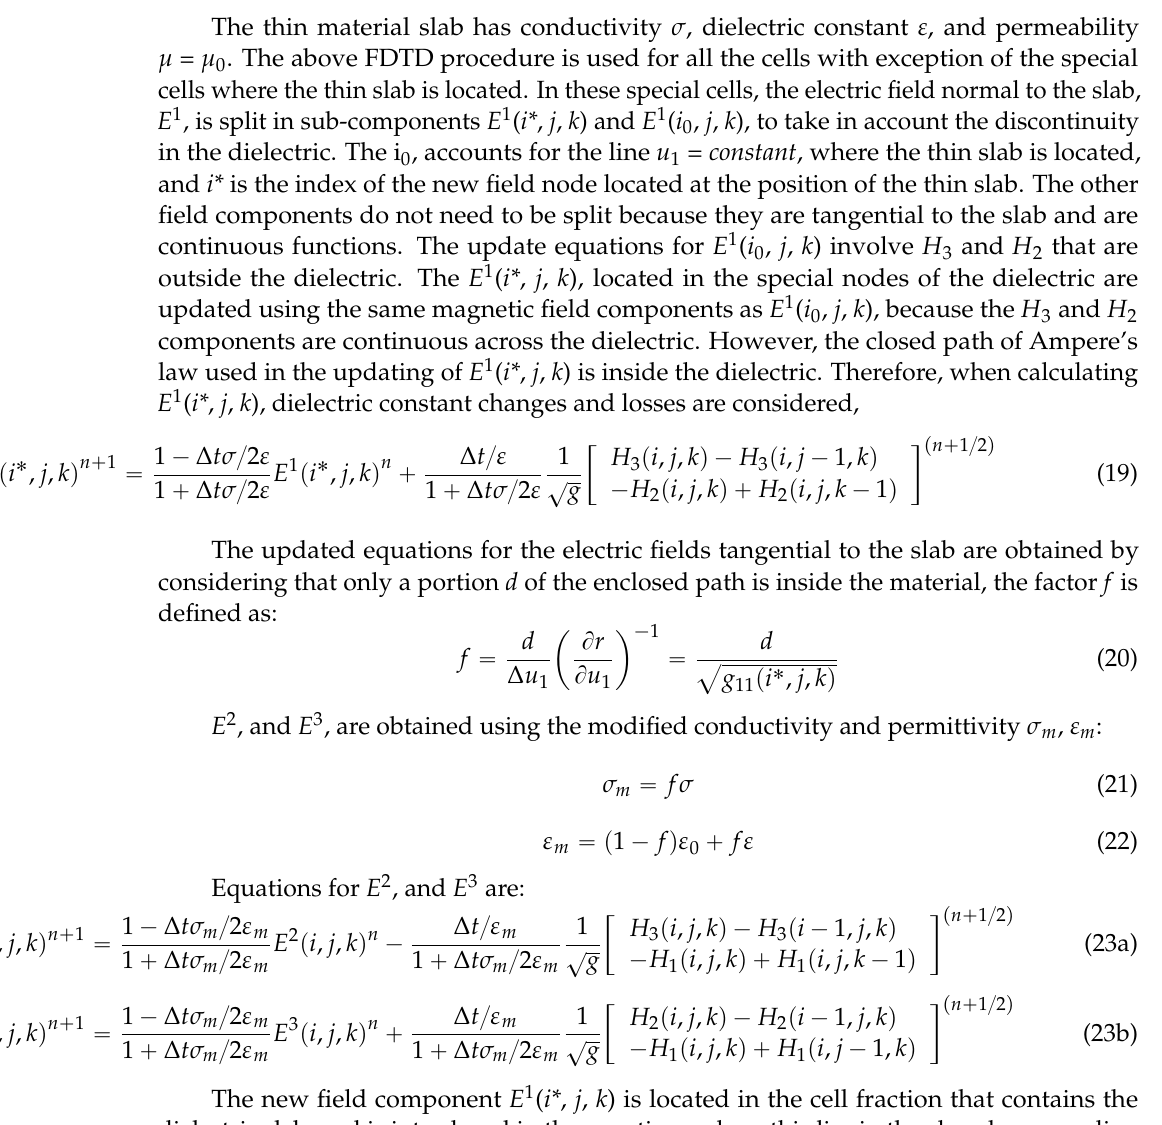
The new field component E 1 ( i* , j , k ) is located in the cell fraction that contains the dielectric slab, and is introduced in the equations where this lies in the closed